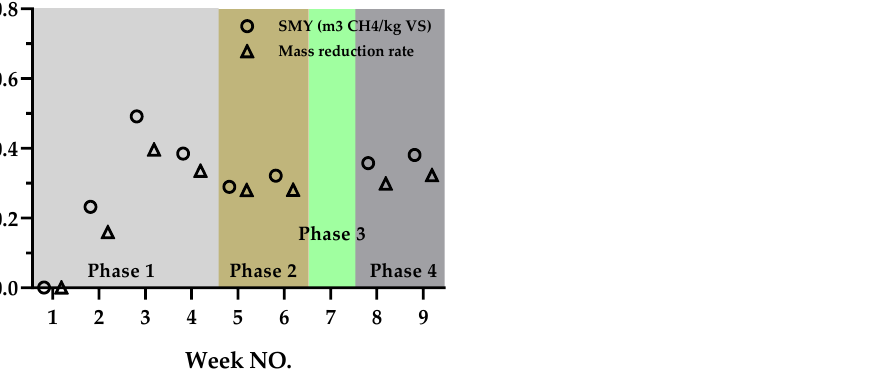
Figure 7. Weekly mass reduction rate and substrate-specific methane yield (SMY) in the anaerobic digestion (AD) process.